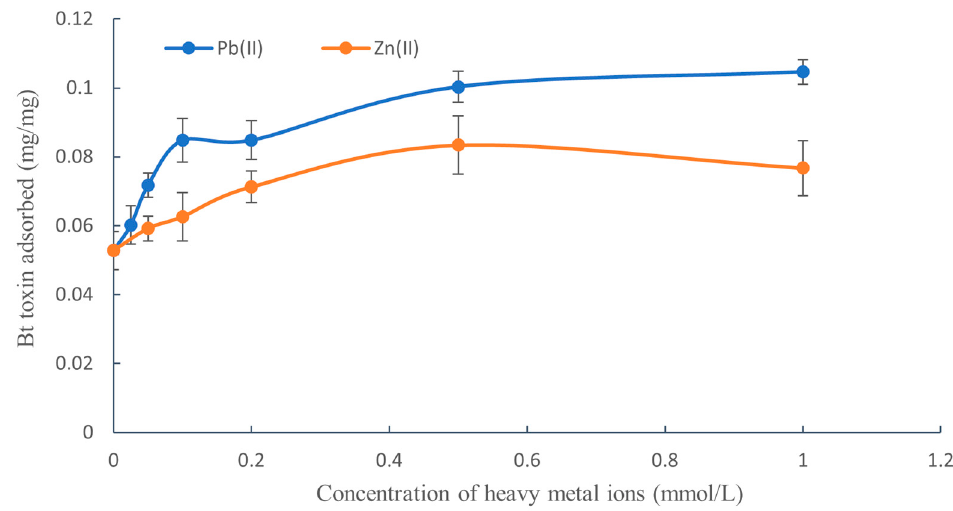
Figure 1. Effect of concentration of Pb(II) or Zn(II) on the adsorption of Bt toxin in black soil.